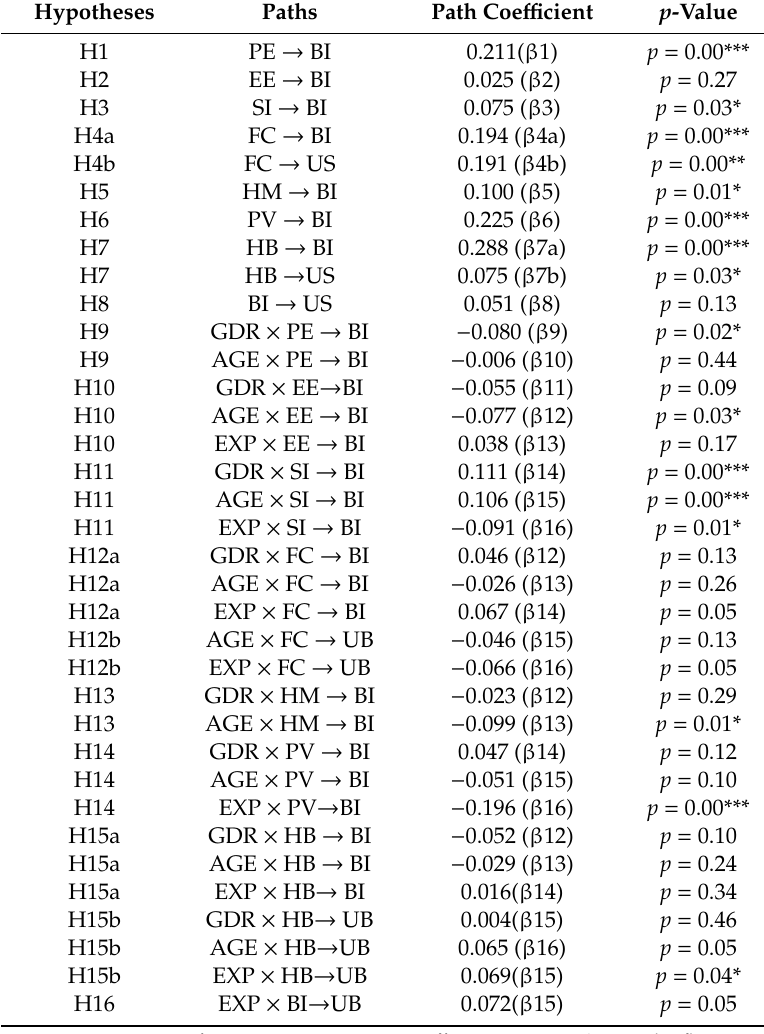
Table 3. Path results of structural